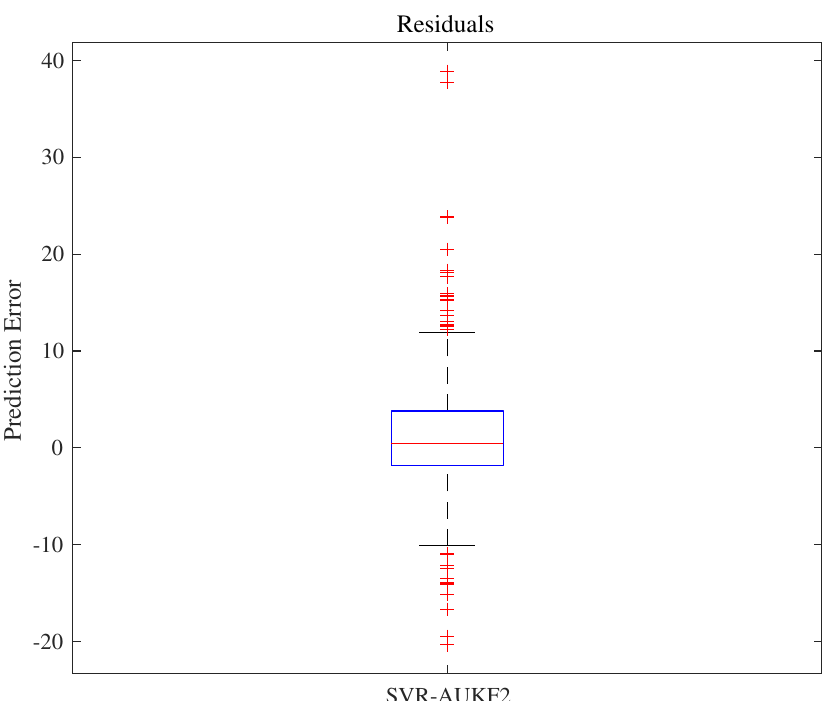
Figure 9. The PM 2.5 concentration prediction of SVR-AUKF2. The prediction residuals of SVR-AUKF2 are shown in Figure 10.